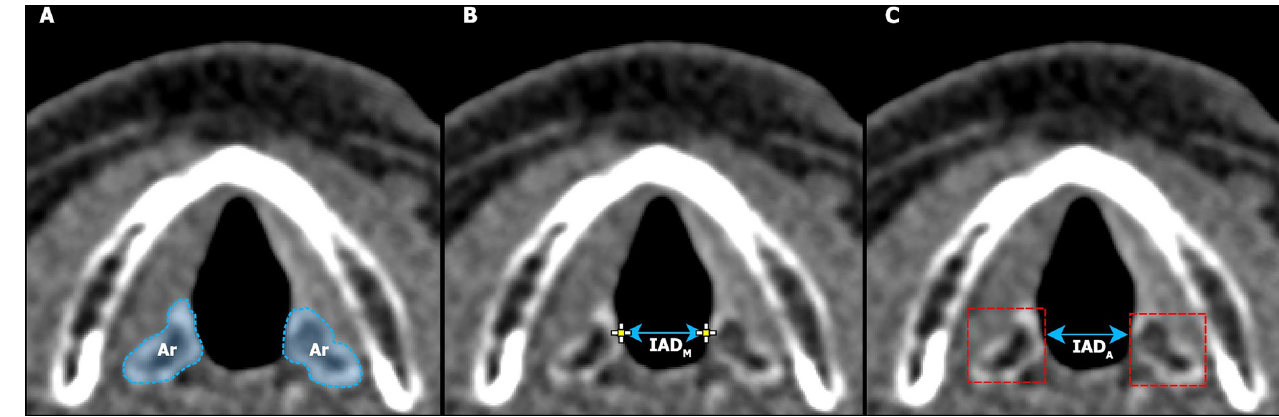
Fig 1. Illustrative diagrams comparing the image annotation techniques. 1A, axial slice through the larynx during voice rest, with the left and right arytenoid cartilages (Ar) marked in blue. 1B, fiducial markers manually placed at the anteromedial aspect of each arytenoid cartilage, with the corresponding IAD M marked. 1C, bounding boxes marked in red around each arytenoid cartilage by the automated machine learning algorithm, with the corresponding IAD A